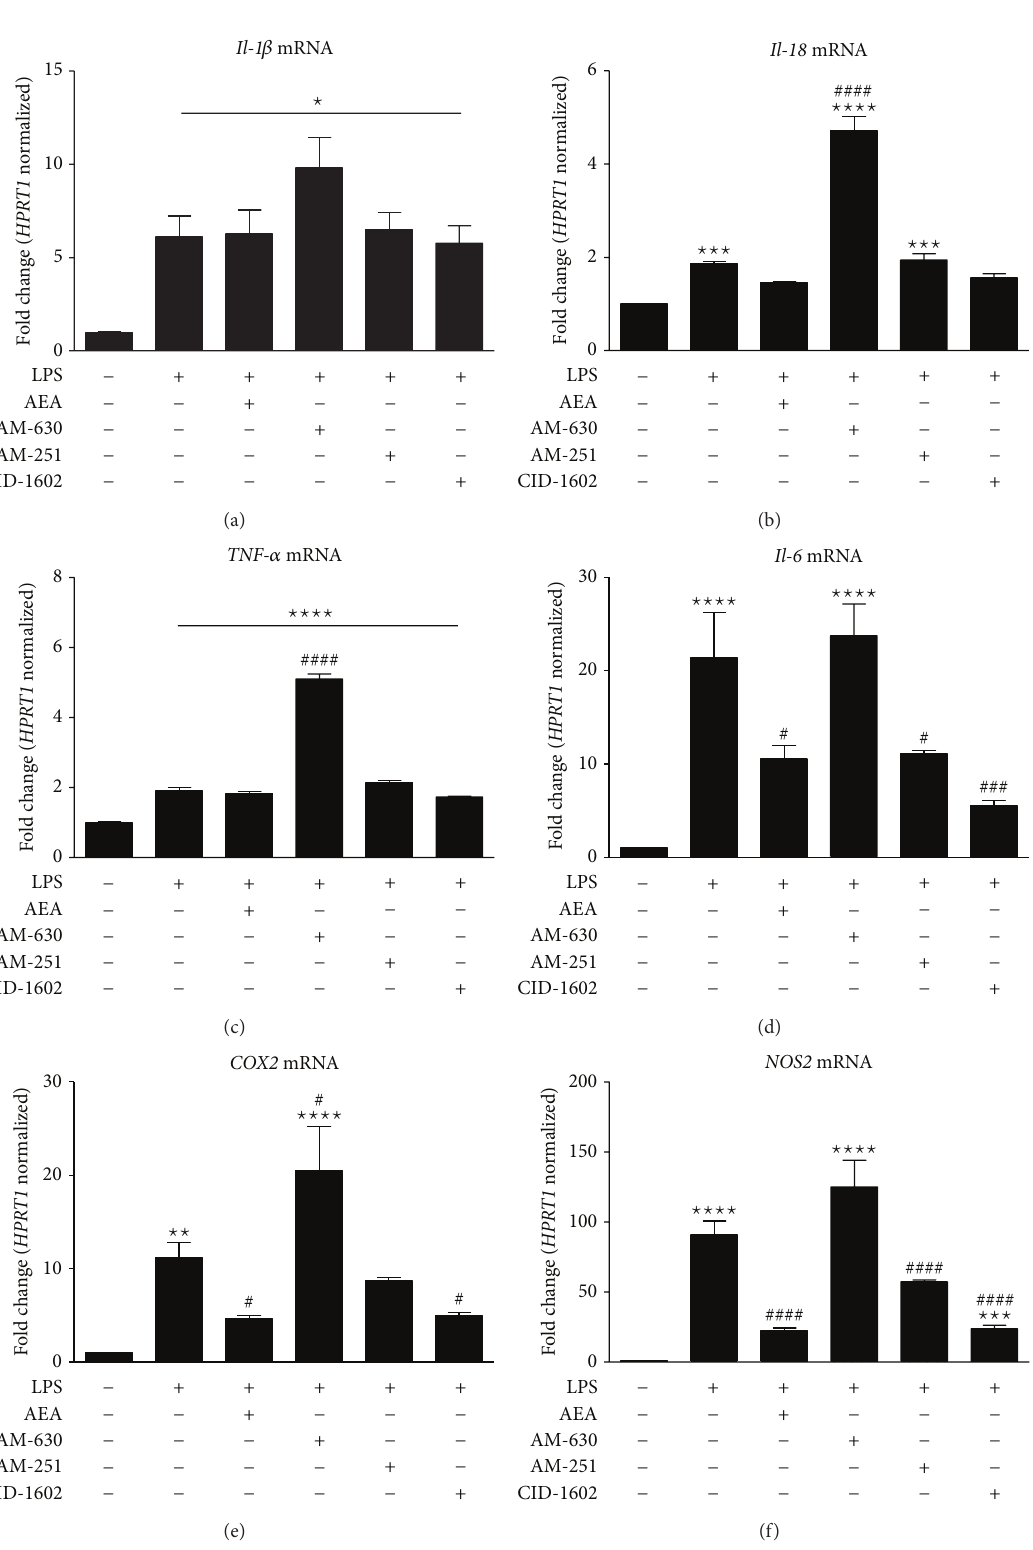
Figure 4: The results of qPCR analysis of the M1 phenotypic markers Tnf- 𝛼 , Il1 𝛽 , Il18, Il6, Cox2, and Nos2 gene expression in rat primary microglial cultures in the presence of the tested compounds. Samples were analyzed 24 hours after LPS stimulation. Data are presented as the mean ± SEM and represent the normalized averages derived from 6 to 8 samples per group. The results are presented as fold-change normalized to the expression of the reference gene Hprt1 and were calculated relative to nonstimulated cells. Statistical analysis was performed using one-way ANOVA followed by Bonferroni post hoc tests; 𝑃 values < 0.05 were considered significant. * It denotes a significant difference versus the nonstimulated control; #, versus the LPS-stimulated